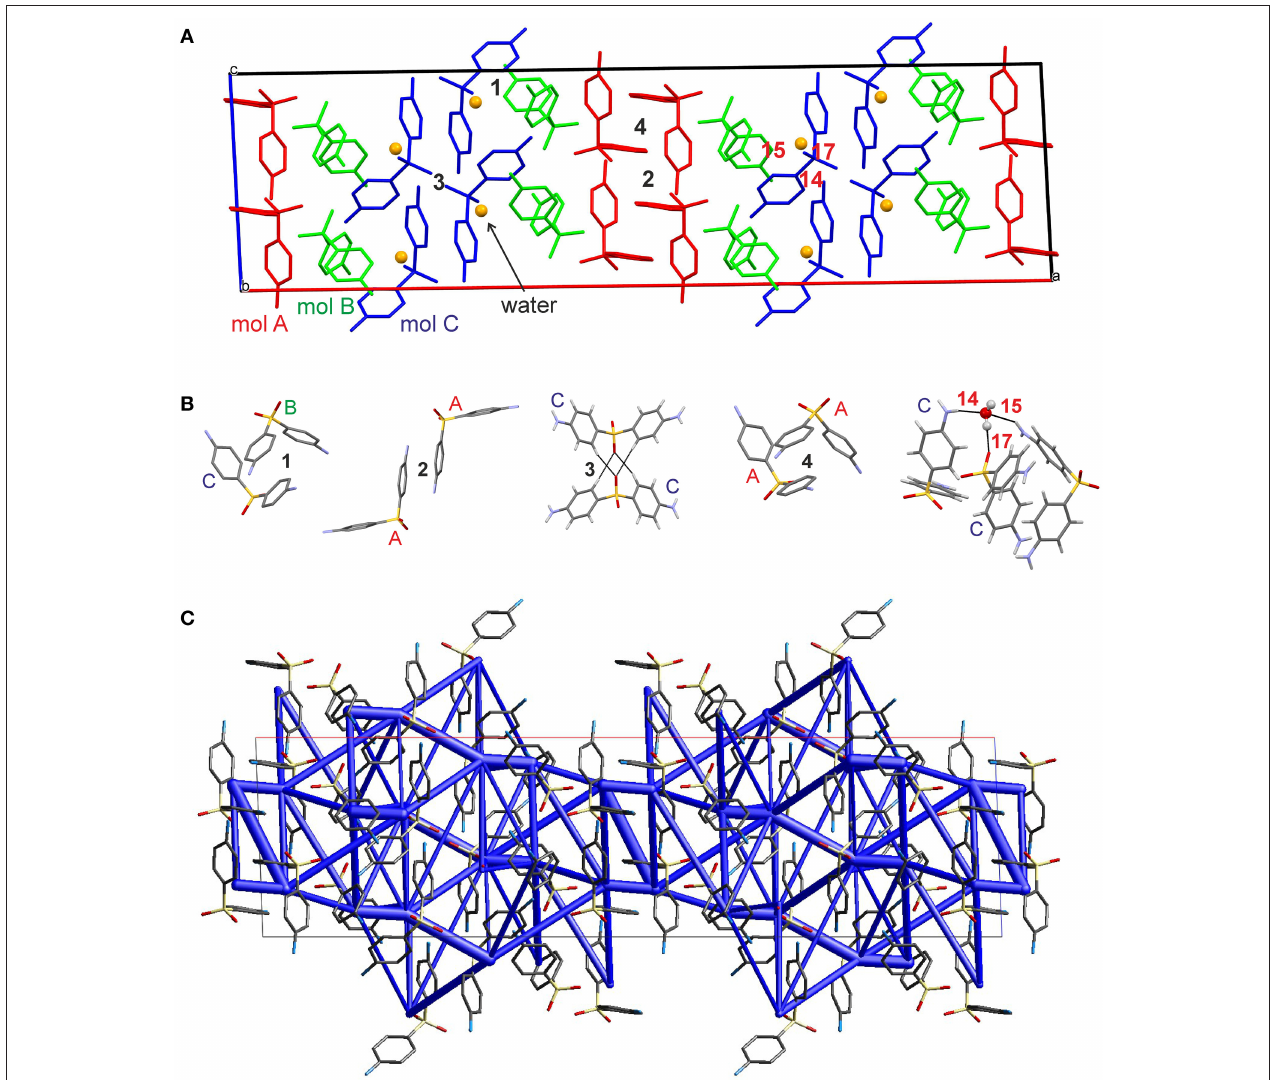
FIGURE 3 | (A) Packing diagram of DDS 0.33-Hy (ANSFON02, Yathirajan et al., 2014) viewed along the crystallographic b axis. The symmetry independent molecules are color coded and hydrogen atoms have been omitted for clarity. Numbers denote key pair-wise intermolecular interactions, which are enlarged in (B) and listed in Table 2 . Hydrogen bonding is indicated with black lines. (C) Energy frameworks (total energy) for 0.33-Hy , viewed along the crystallographic b axis. The energy scale factor is 80, and interaction energies with magnitudes smaller than 15 kJ mol − 1 have been omitted. For additional views see Supplementary Material.